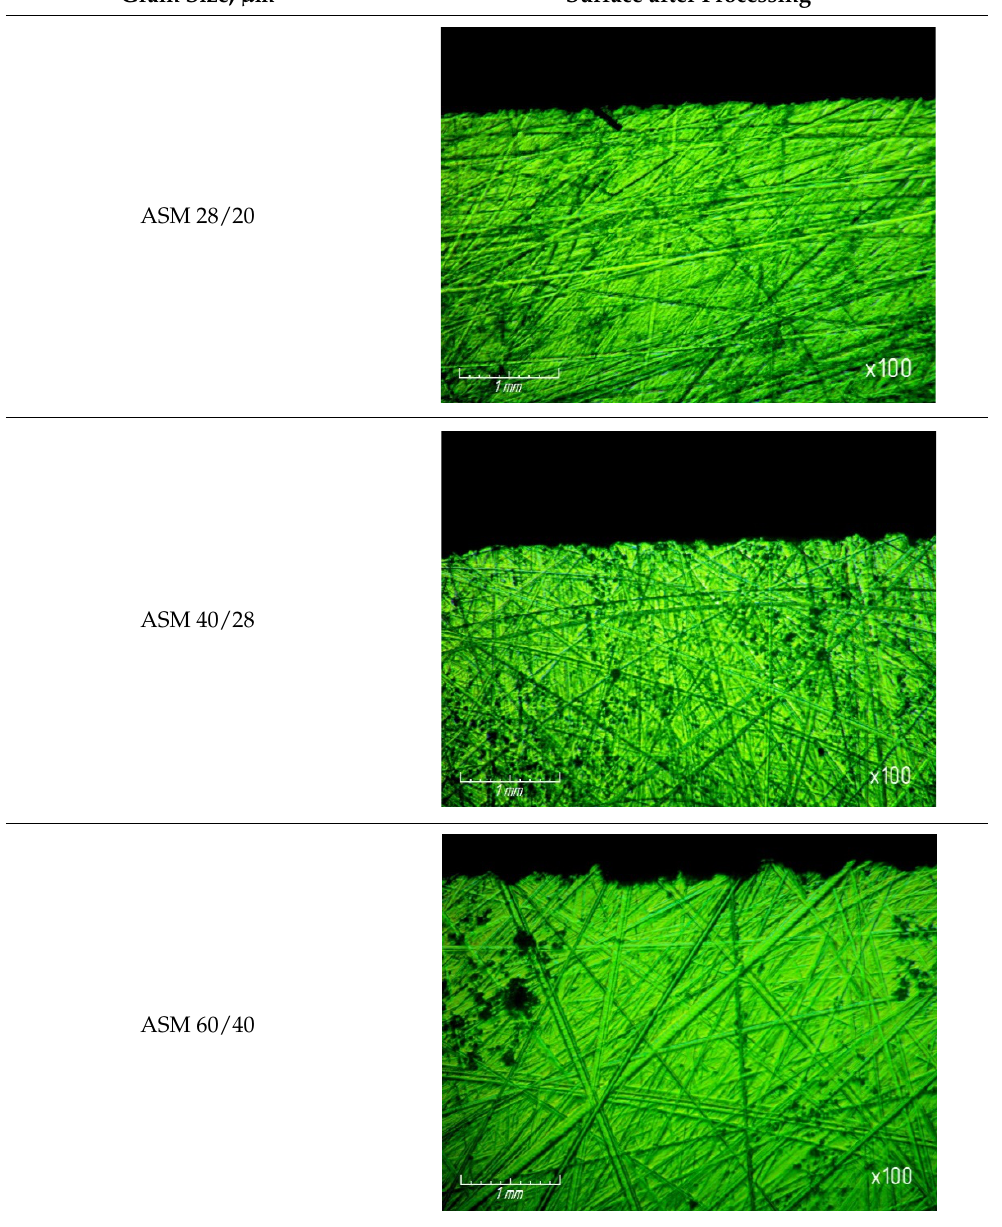
With increasing grain size, the roughness of the treated surface increases proportionally from Ra = 0.015 microns to Ra = 0.244 microns (Figure 9).